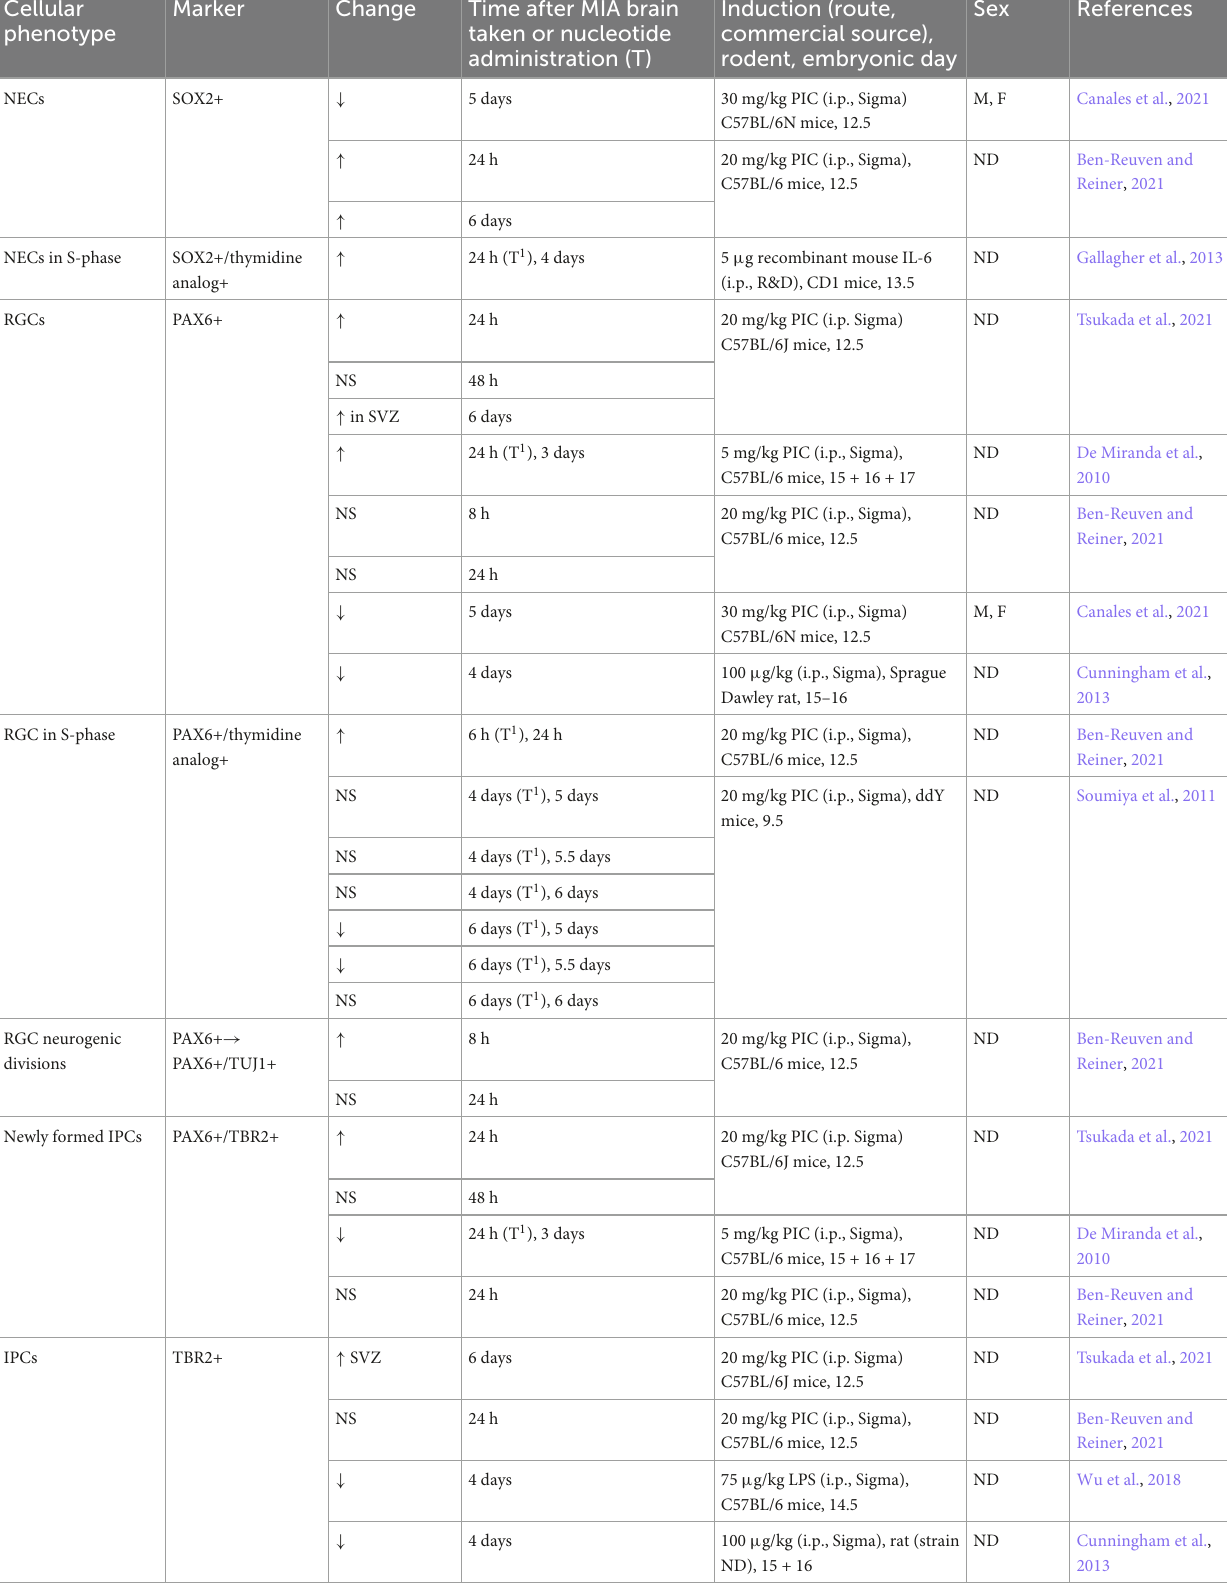
TABLE 2 Cell fate phenotypes in fetal MIA offspring cortex relative to controls. Cellular phenotype